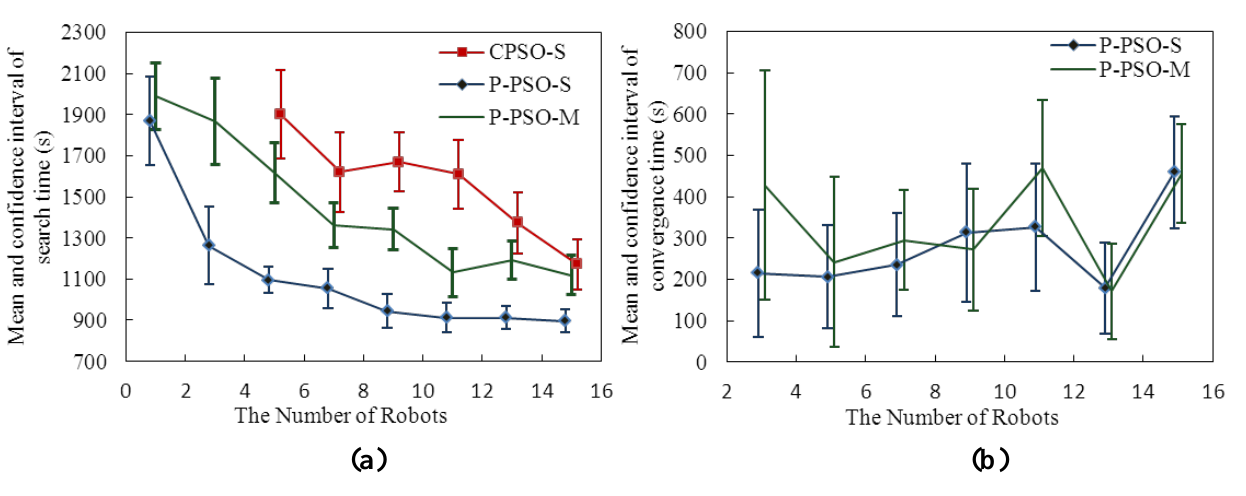
Figure 6. (a) The search time of P-PSO and CPSO based gas source localization in large-scale plume environments; (b) The convergence time of P-PSO.